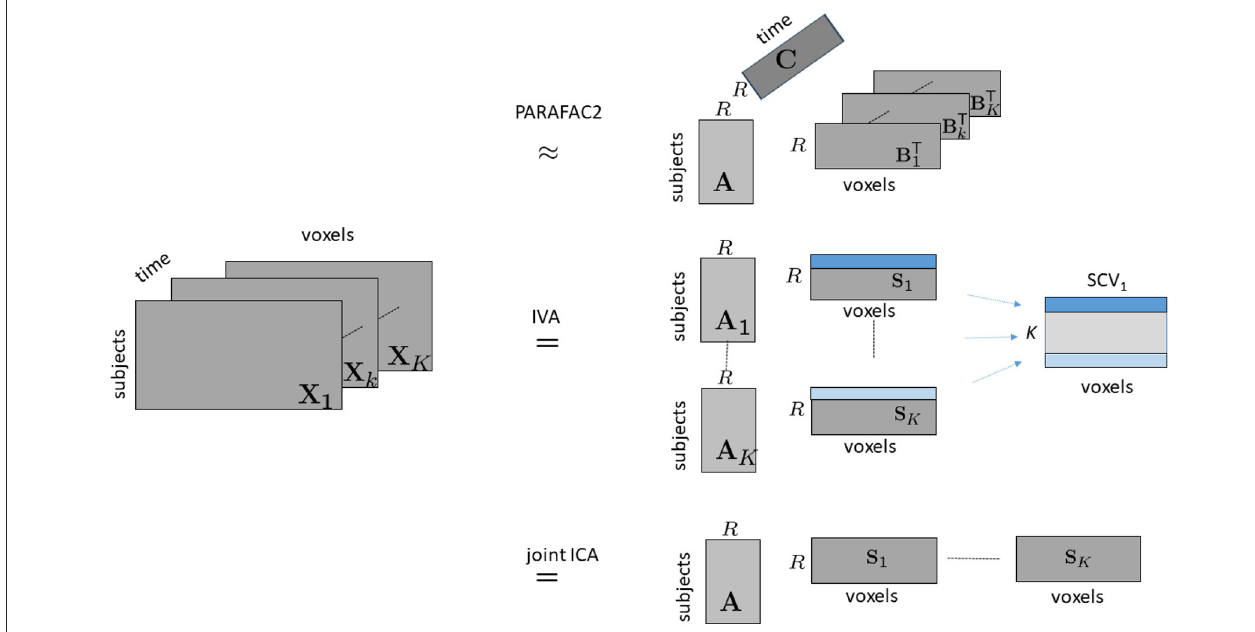
FIGURE 1 | Illustration of modeling time-evolving data in the form of a subjects by voxels by time tensor using PARAFAC2, IVA and joint ICA. Following the notation in the literature on ICA/IVA, we use S k , for k = 1,..., K , to denote the factor matrix in the voxels mode for joint ICA and IVA, where S k = B T k